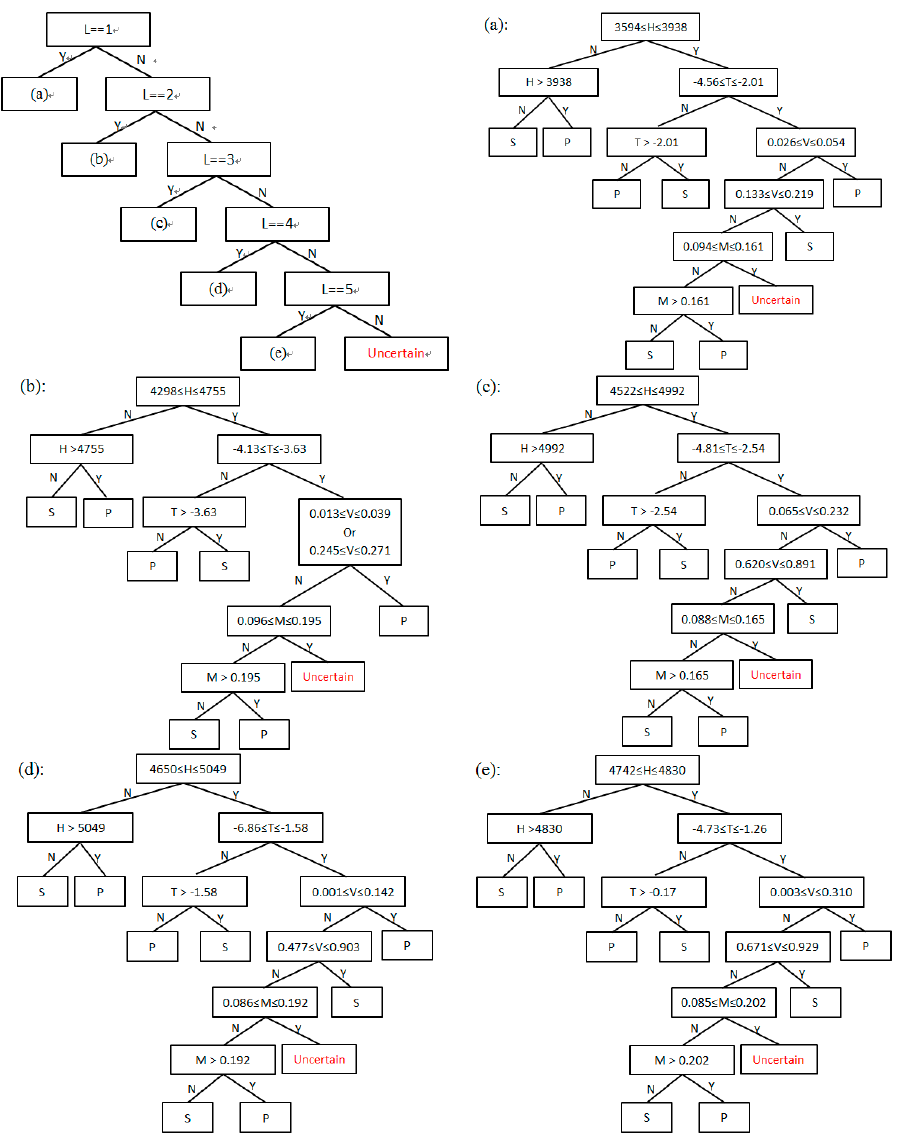
Figure 5. Classification Decision Tree (P: permafrost, S: seasonally frozen ground): ( a ) in the first latitude zone; ( b ) in the second latitude zone; ( c ) in the third latitude zone; ( d ) in the fourth latitude zone; and ( e ) in the fifth latitude zone.